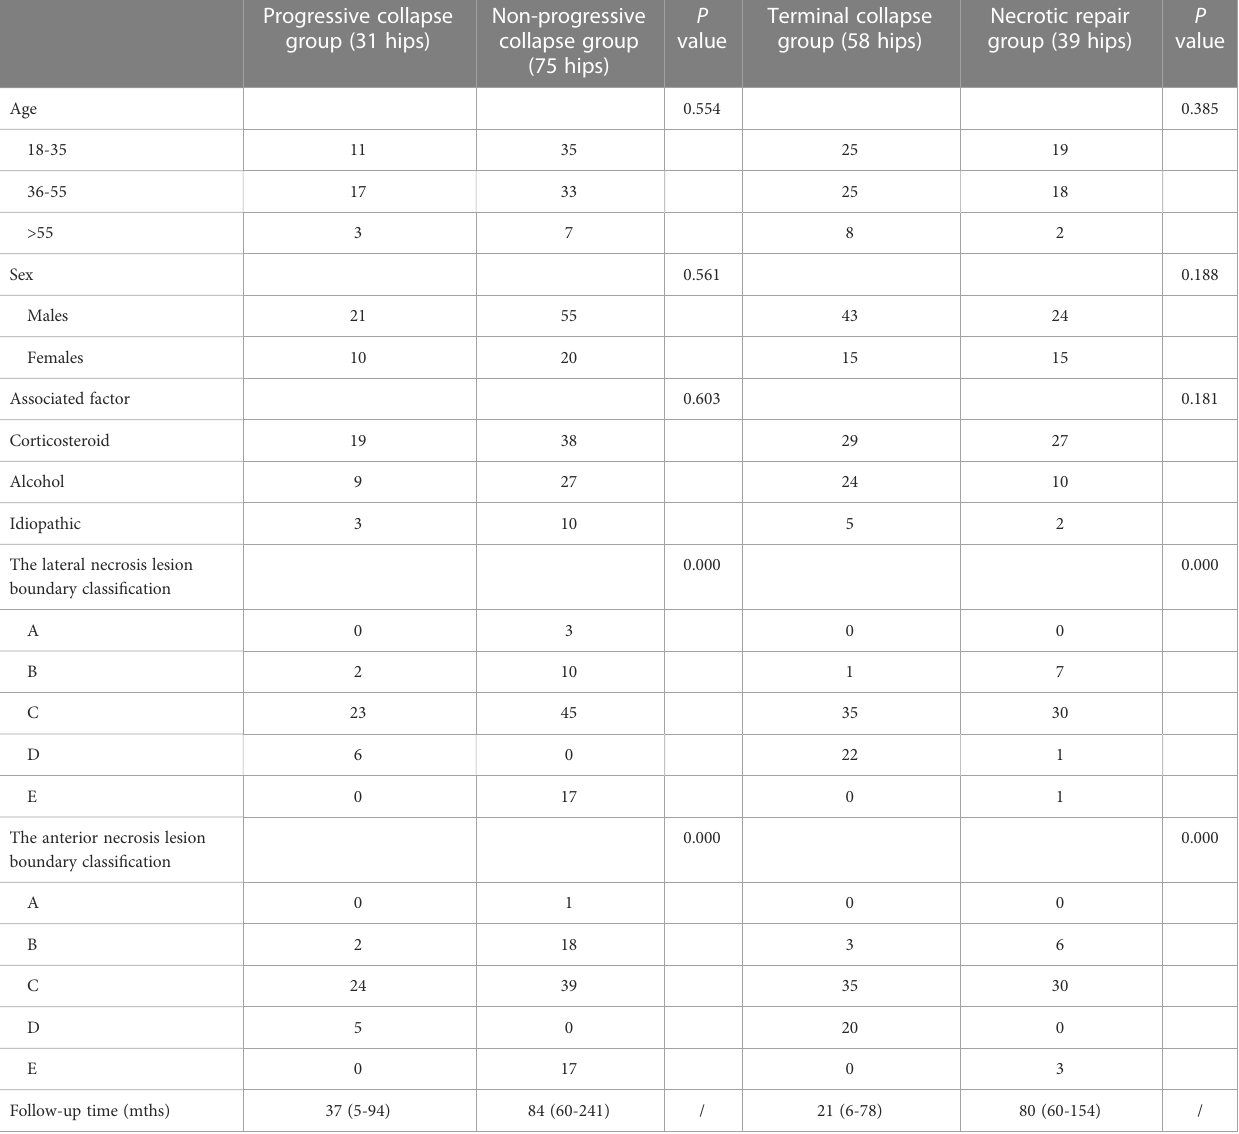
TABLE 1 The correlation between the characteristics of ARCO stage II-IIIA and